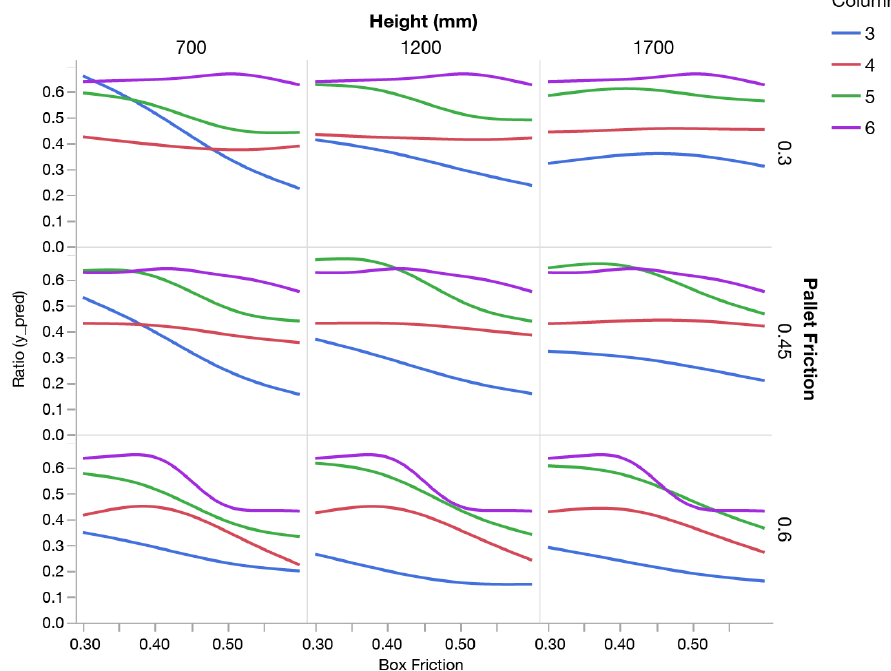
Figure 13. Effect of the friction coefficient of packages on board bending ratio by pallet friction, payload height (mm), and number of columns.